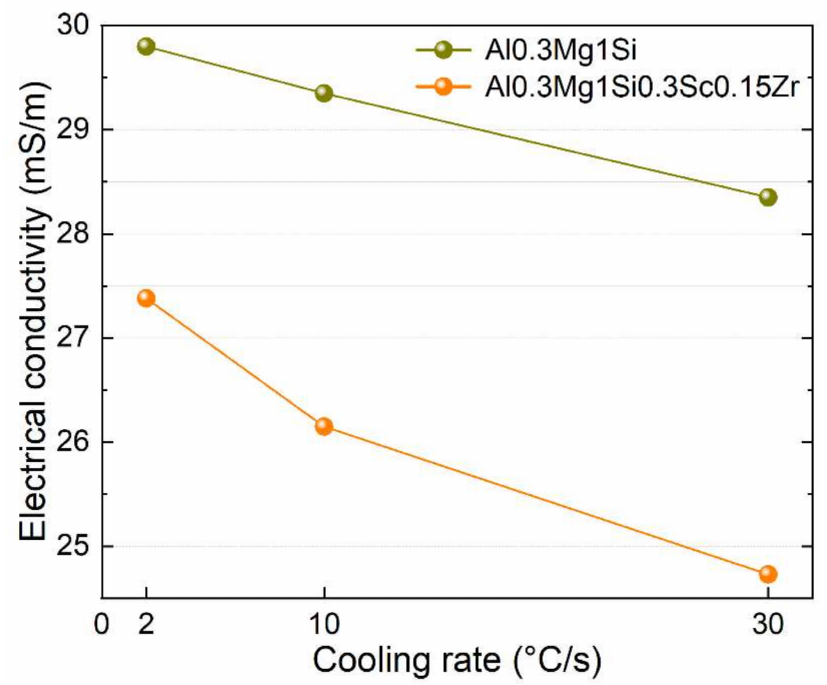
Figure 4. Electrical conductivity of alloys depending on the cooling